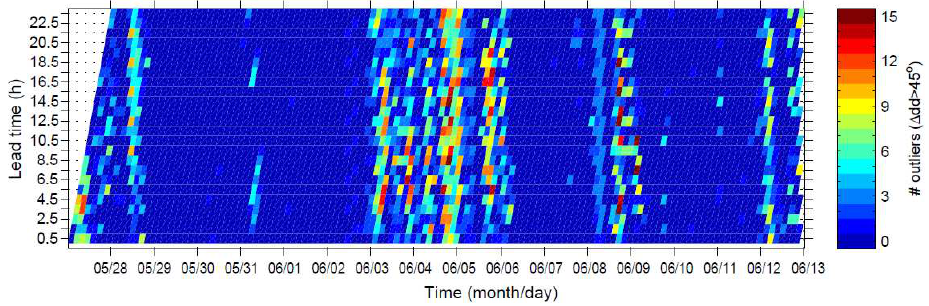
Fig. 4. Wind direction outliers in the time series from 28 May to 13 June 2009, during the Muehleberg 2009 validation campaign: outliers are defined as (modelled-measured) wind direction values exceeding 45 degrees at all COSMO-2 layers ranging from the ground layer up to layer #15 (colour scale ranges from blue equal “no outlier” to dark red equal to “all 15 layers” have outliers values). Each data point is expressed for any lead time in hours ranging from the COSMO-2 analysis time to a one day forecast, by step of 0.5 h. The time series from 3–6 June (see the synoptic weather map in Fig. 5) is an example of poorly predicted weather conditions. These statistics are performed using only wind speed conditions higher than 2ms − 1 .